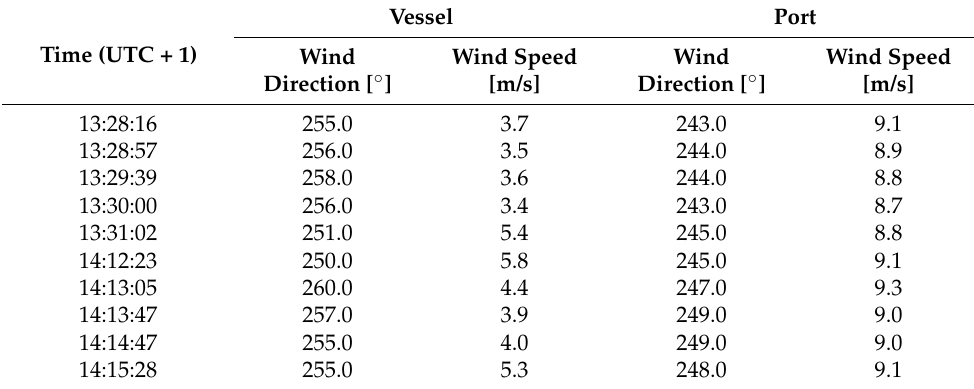
Table 1. Actual wind measurements.